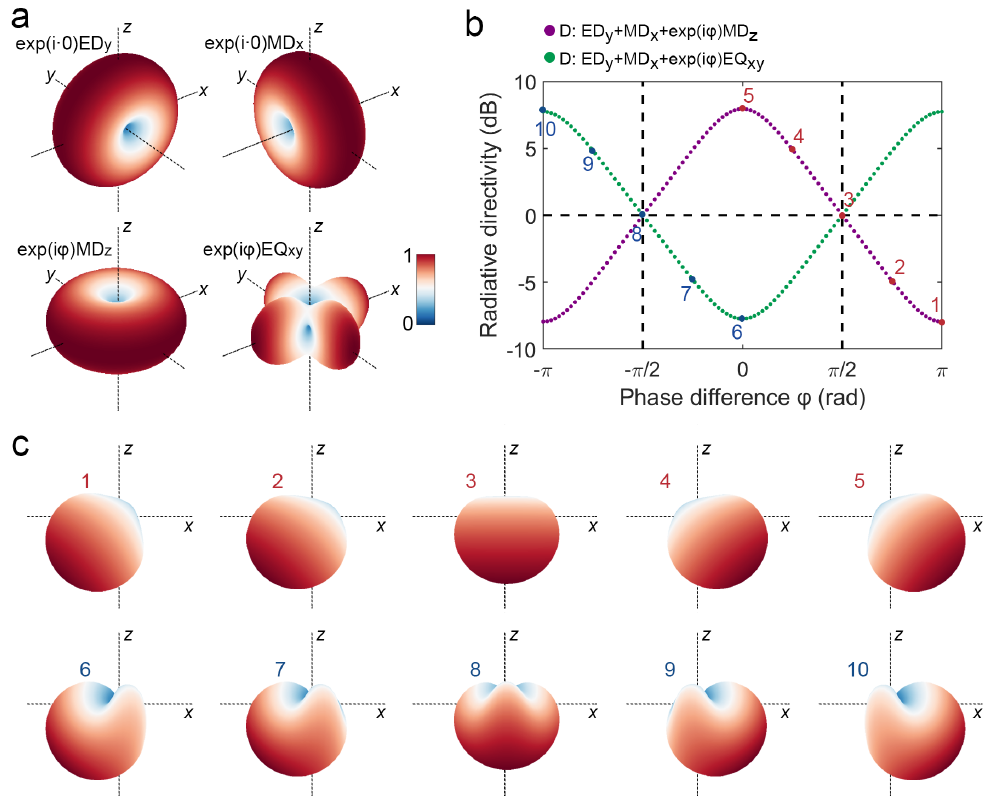
Figure 5. Directional deflection of far-field radiation with an interference phase difference: ( a ) Far- field radiation pattern of unit ED y and MD x with phase angle 0, MD z and EQ xy with phase angle ϕ ; ( b ) D directivity varies with the interference phase difference ϕ ; ( c ) Far-field radiation patterns corresponding the points numbered 1–10 in ( b ),